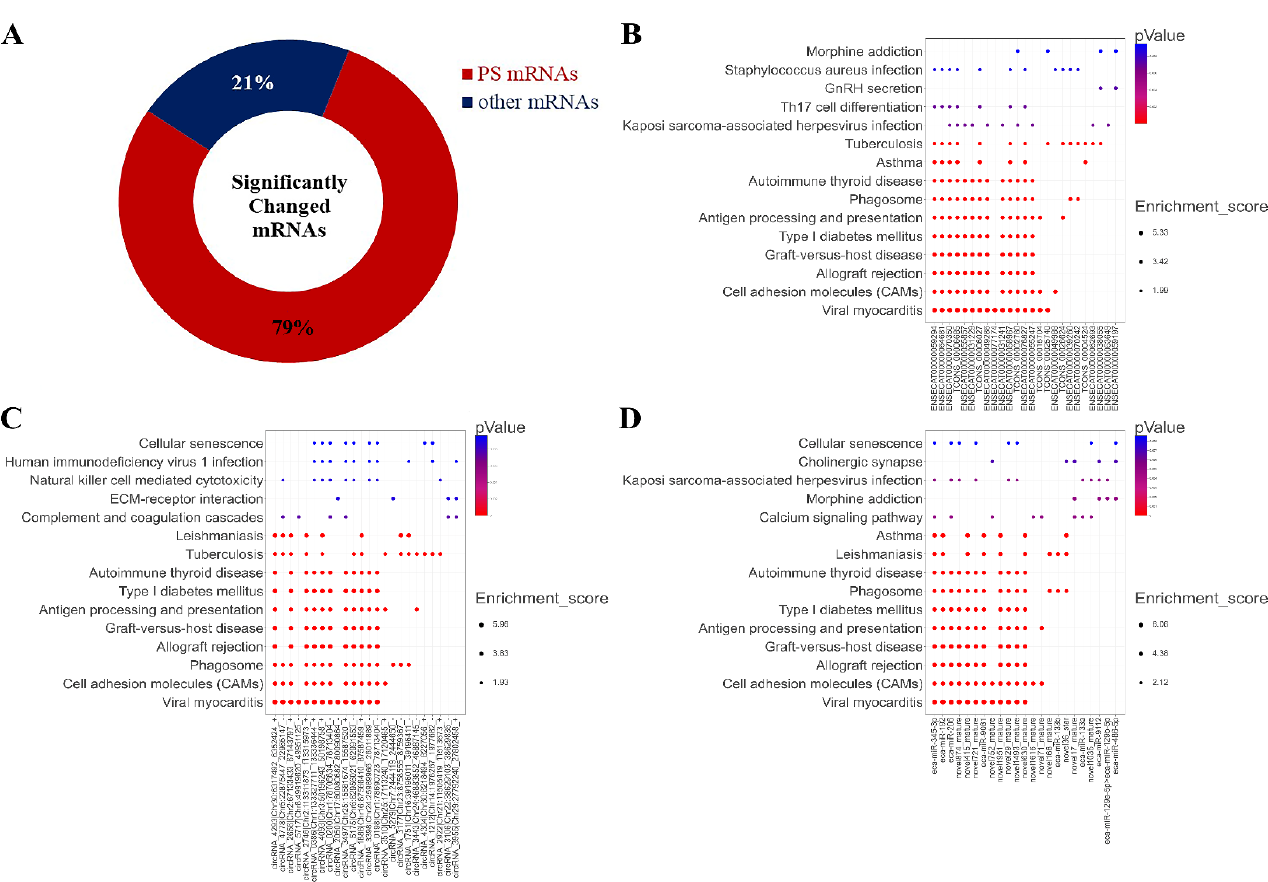
Figure 10. Significantly changed mRNAs after exposure to L-leu and bubble maps of KEGG Pathway Enrichment. ( A ) The ring indicated significantly changed mRNAs in the equine SCs after exposure to L-leu; ( B – D ) Gene enrichment pathways regulated by differentially expressed lncRNAs, cricRNAs, and miRNAs, respectively.